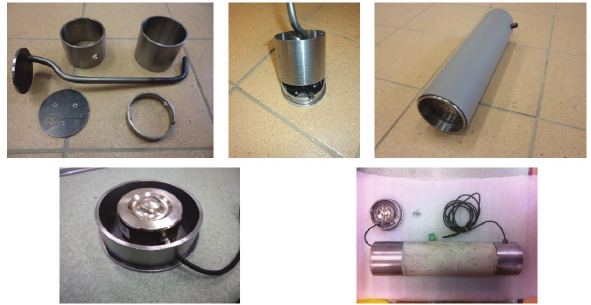
Figure 1: Components of instrumentation pile model.